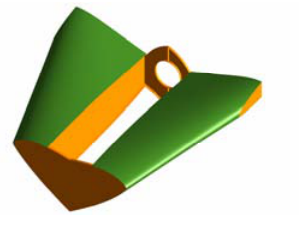
Fig 24. Endurance and range versus flight speed